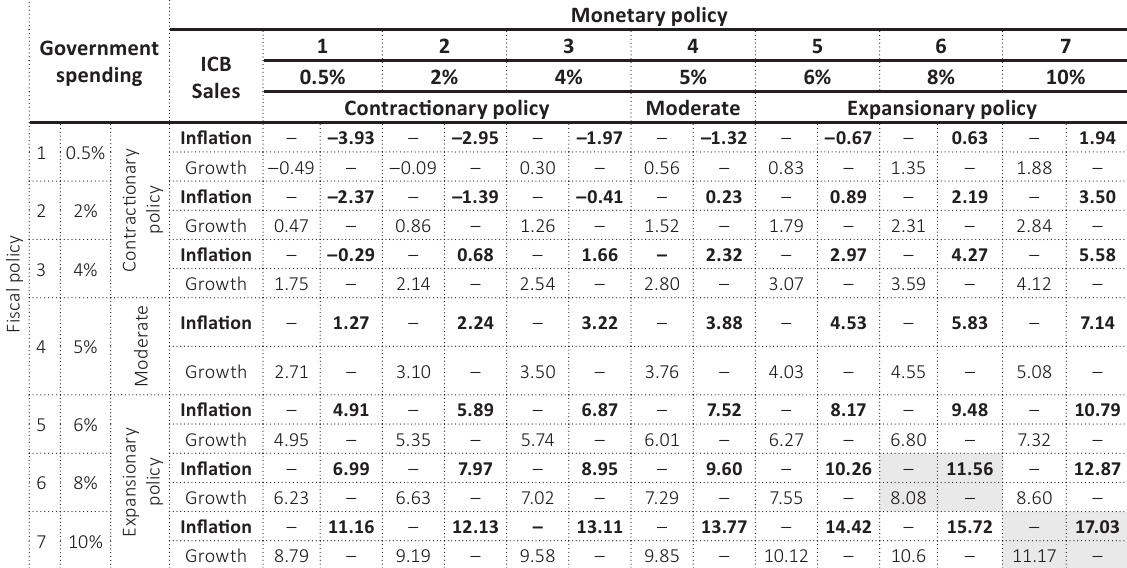
Table 2. Iraqi monetary-fiscal game – payoff